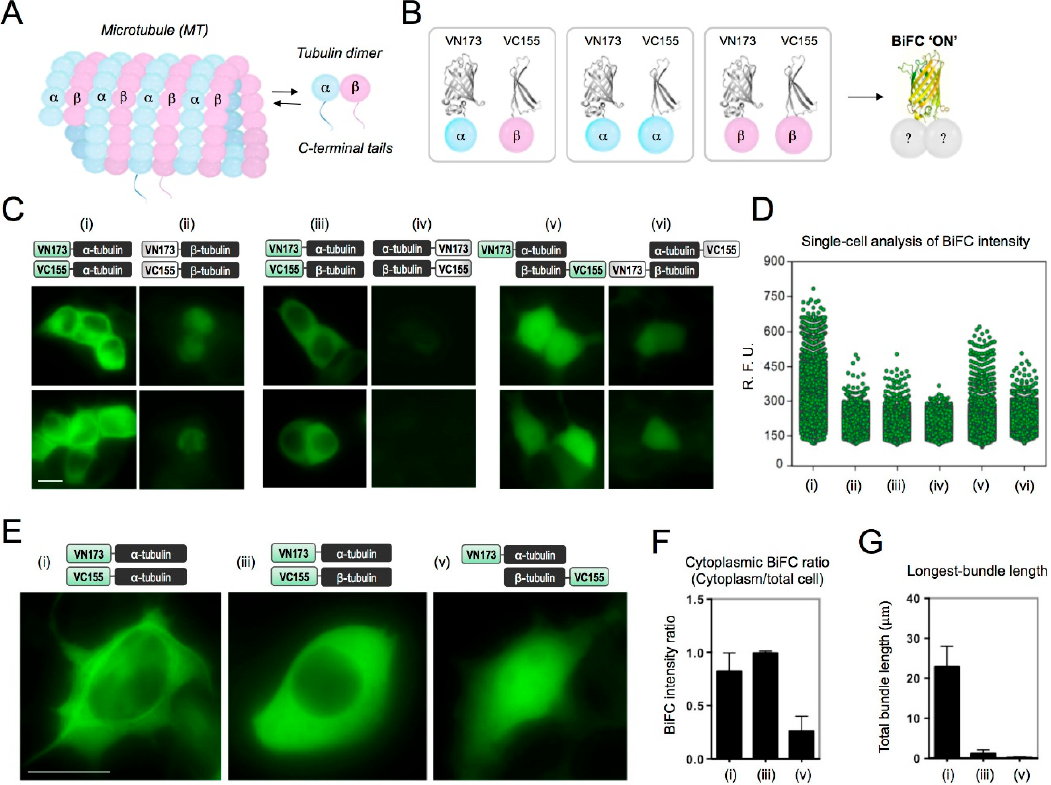
Figure 1. Determination of Bifluorescence Complementation (BiFC) labeling site for α / β -tubulin. ( A ) Structure of a microtubule and α / β -tubulin dimer. ( B ) Diagram of tubulin pairs fused with BiFC compartment. As a fluorescence turn-on sensor, Venus fluorescence turns on upon tubulin-tubulin interaction. ( C ) BiFC fluorescence images of HEK193 cells expressing diverse tubulin-BiFC pairs (i to vi). HEK293 cells were transfected with diverse combinations of α - and β -tubulin-BiFC pairs for 72 h, and were imaged by using Operetta ® . Scale bar, 20 µ m. ( D ) Single-cell analysis of cellular BiFC intensities. BiFC fluorescence intensities were measured using Harmony 3.1 software and plotted using GraphPad Prism software. A total of 19,000 cells were analyzed for each experiment and each dot represents an individual cell. ( E ) High resolution (1000 × ) images of tubulin-BiFC cells. Scale bar, 20 µ m. ( F , G ) Quantification of cytoplasmic BiFC fluorescence intensity ( F ) and total bundle length ( G ) of tubulin-BiFC cells. The fluorescence intensities in the cytoplasm or total cell area and total bundle lengths were quantified using Harmony 3.1 software. Data represent the mean ± SD, n = 20.